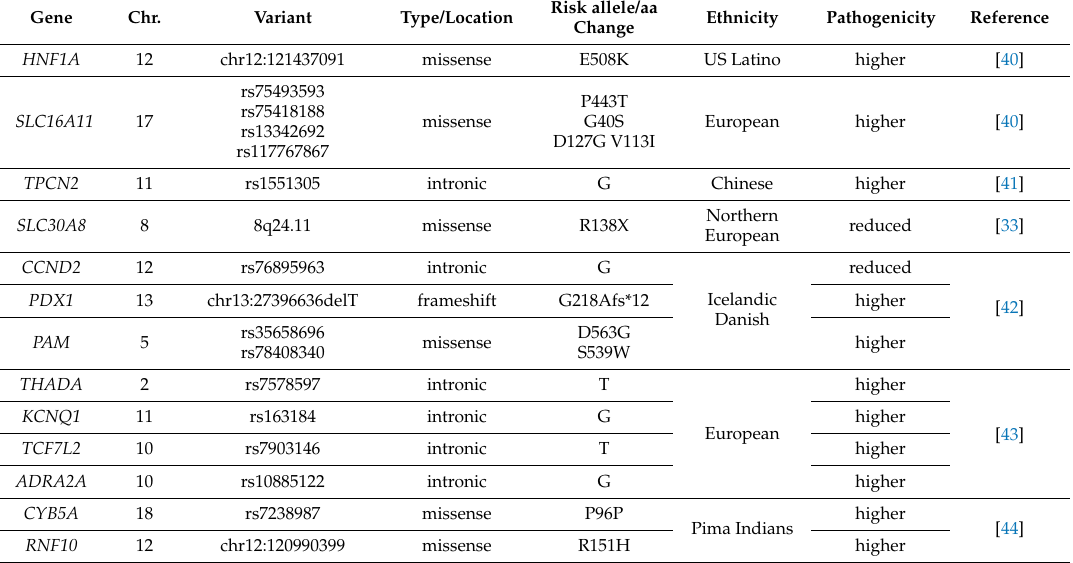
Table 1. Rare-coding and non-coding genetic variants implicated in pathogenesis of type 2 diabetes (T2D).